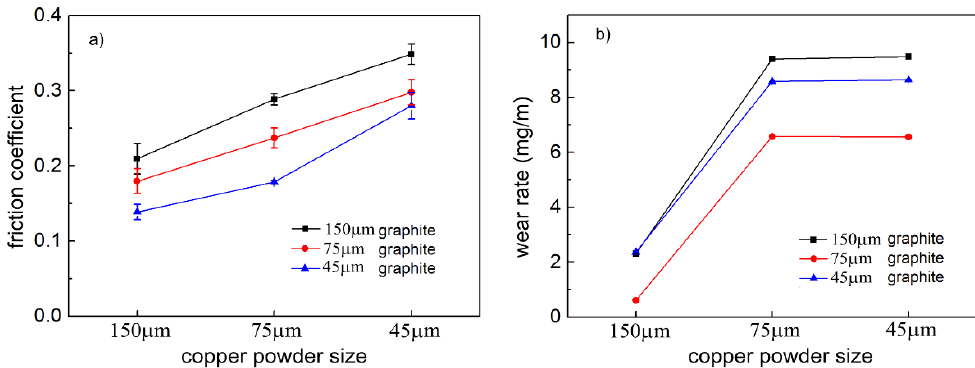
Figure 4. Friction and wear properties of the copper-graphite composites: ( a ) friction coefficient, ( b ) wear rate.